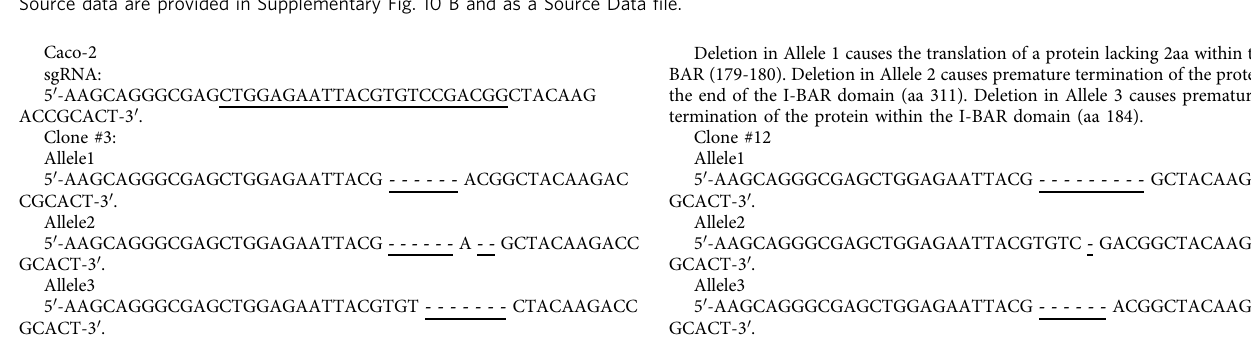
Fig. 9 Genetic removal of IRSp53 leads to defects in murine kidney morphology. a Hematoxylin and eosin staining of kidneys explanted from wild-type (WT) and IRSp53 -KO adult mice were fi xed, processed and paraf fi n embedded. Left: Low magni fi cation images. Right: magni fi ed images of the red (tubular phenotype) and blue (glomerular phenotype) boxes on the left. Black arrowheads, abnormal irregular distributions and shapes of the nuclei in the IRSp53 - KO kidneys; yellow ellipses, areas with disarrayed and convoluted tubules; yellow arrowheads, glomerular tuft microcystic alterations. Scale bar, 50 µ m. b Quanti fi cation of the renal alteration score. Kidneys from wild-type (WT) and IRSp53 -KO mice were analyzed and scored for defects in renal morphology (see also Fig. S9B and Methods). Data are means ± SD. WT, n = 8 (4 M, 4 F); KO, n = 16 (6 M, 10 F). P value, student ’ s t -test two-tailed. *** p < 0.001. Source data are provided in Supplementary Fig. 10 B and as a Source Data fi